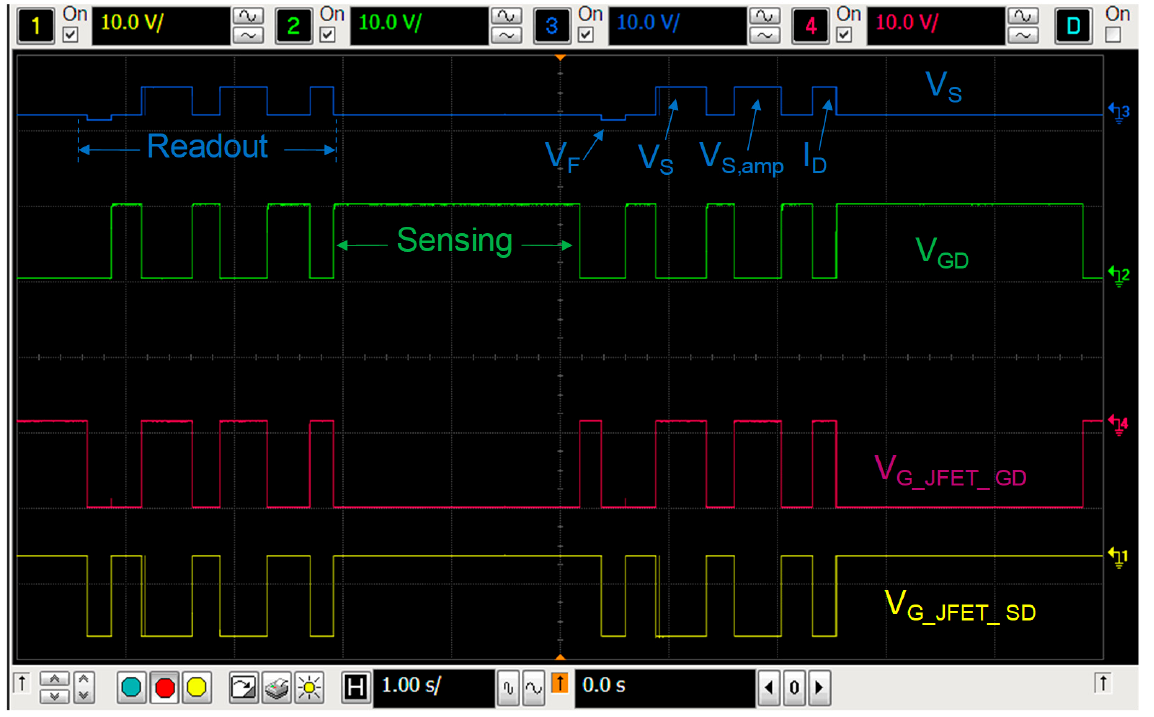
Figure 4. Measurement chronogram: In blue the source voltage is displayed; in green the gate voltage of the MOSFET; in red the gate voltage of the JFET_GD and, in yellow, the gate voltage of the JFET_SD.